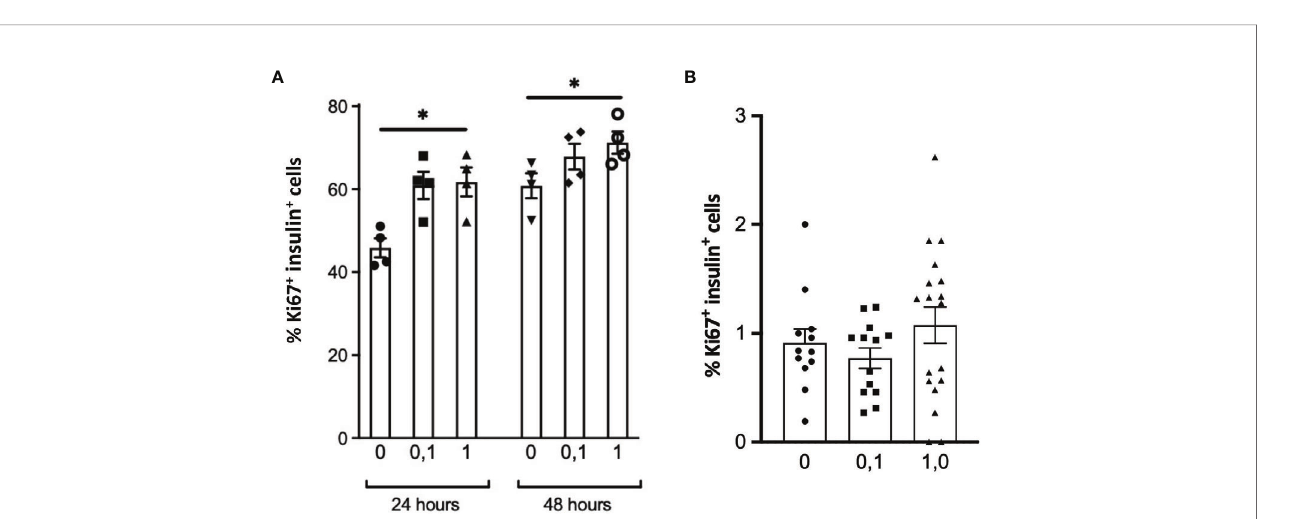
FIGURE 5 | DNA synthesis in INS1E cells (A) or b -cells within isolated adult mouse islets (B) treated without or with 0.1 or 1 m g/ml PTN for 24 h or 48 h (A) , or 48 h (B) as measured from the co-localization of insulin and Ki67 by immunohistochemistry. *p < 0.05 vs. control without PTN. [n=4 replicates/experiment in (A) , n=11-18 separate islets per treatment in B